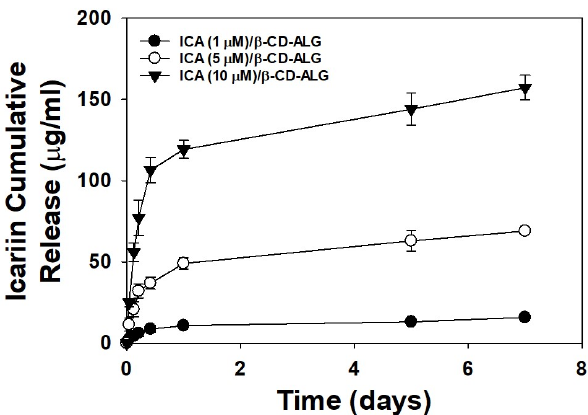
Figure 4. In vitro cumulative icariin (ICA) release from ICA (1 µ M) / β -CD-ALG, ICA (5 µ M) / β -CD-ALG, and ICA (10 µ M) / β -CD-ALG (n = 4 per group).